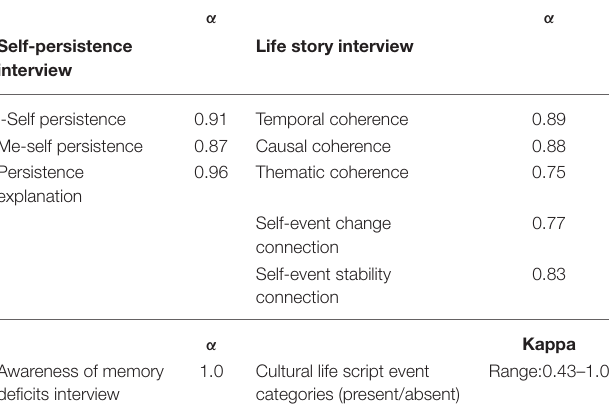
TABLE 4 | Inter-rater reliability measures for double-coded